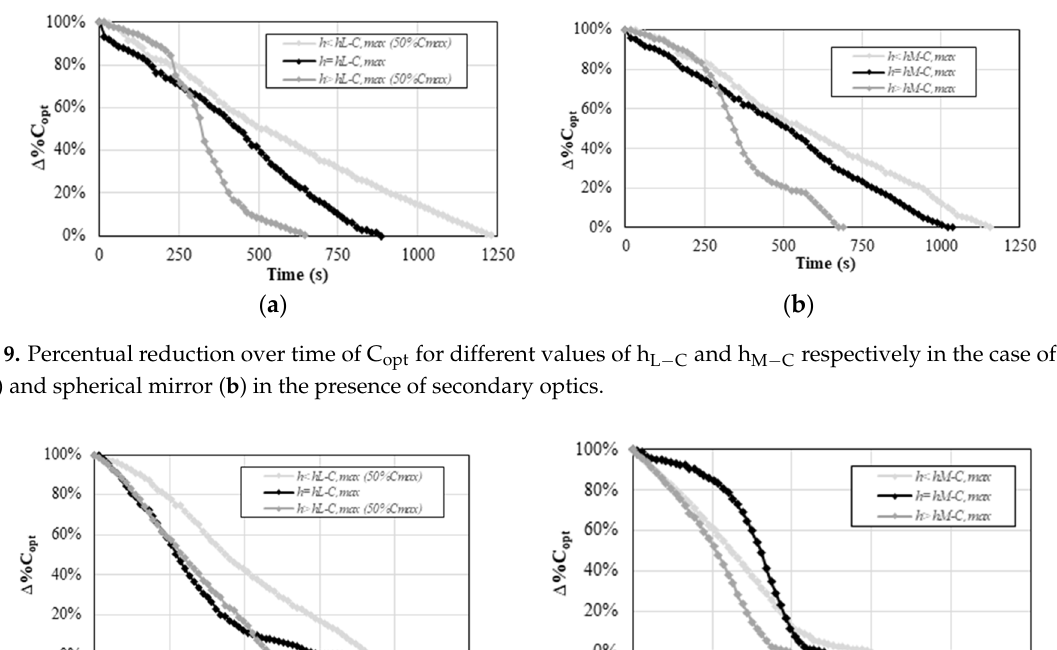
Figure 8. Reduction over time of C opt for different values of h L − C and h M − C respectively in the case of Fresnel lens ( a ) and spherical mirror ( b ) in absence of secondary optics.